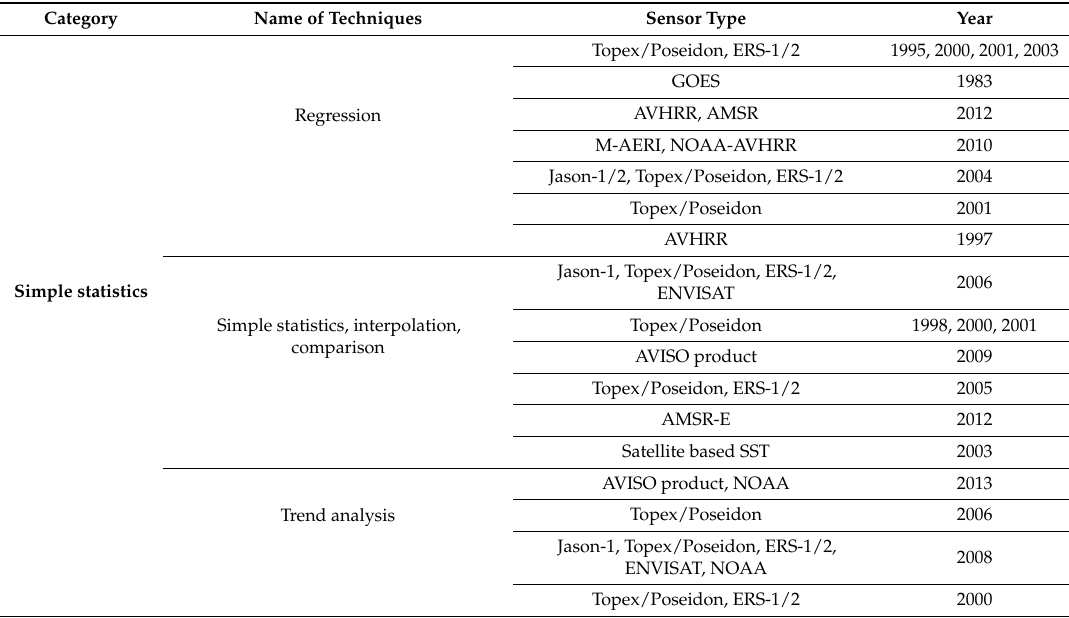
Table 2. Methods used to estimate ocean/sea subsurface water temperature along with the sensor